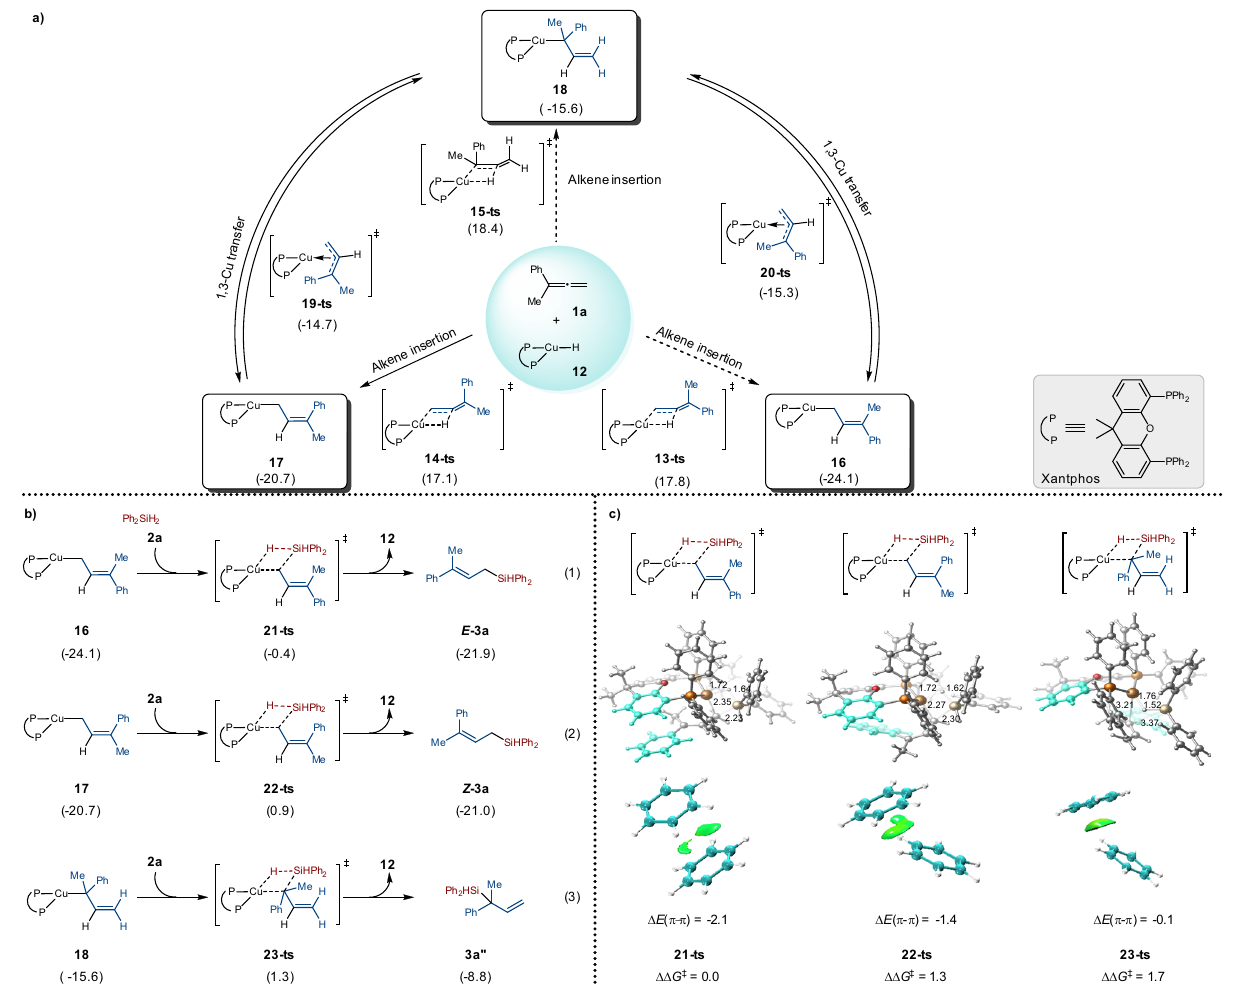
Fig. 6 Computational study. a DFT calculations for the Cu-catalyzed hydrocupration of allene 1a . b Gibbs free energies required for the σ -bond metathesis step of Ph 2 SiH 2 2a and three allylic copper intermediates 16 , 17 and 18 . c DFT calculations on the π - π interaction between the phenyl group of Xantphos and the phenyl group of the allene. Calculations were performed using Gaussian 16 at the M06-L/SDD-6-311 + G(d,p)/SMD(THF)//B3LYP-D3(BJ)/ LANL2DZ-6-31G(d) level of theory and the values are shown in kcal/mol.